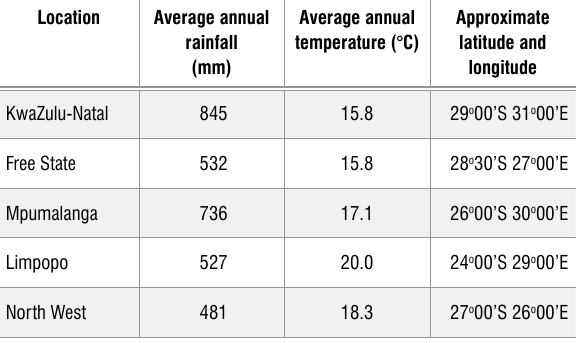
Sources: average annual rainfall and temperature 38 ; approximate latitude and longitude